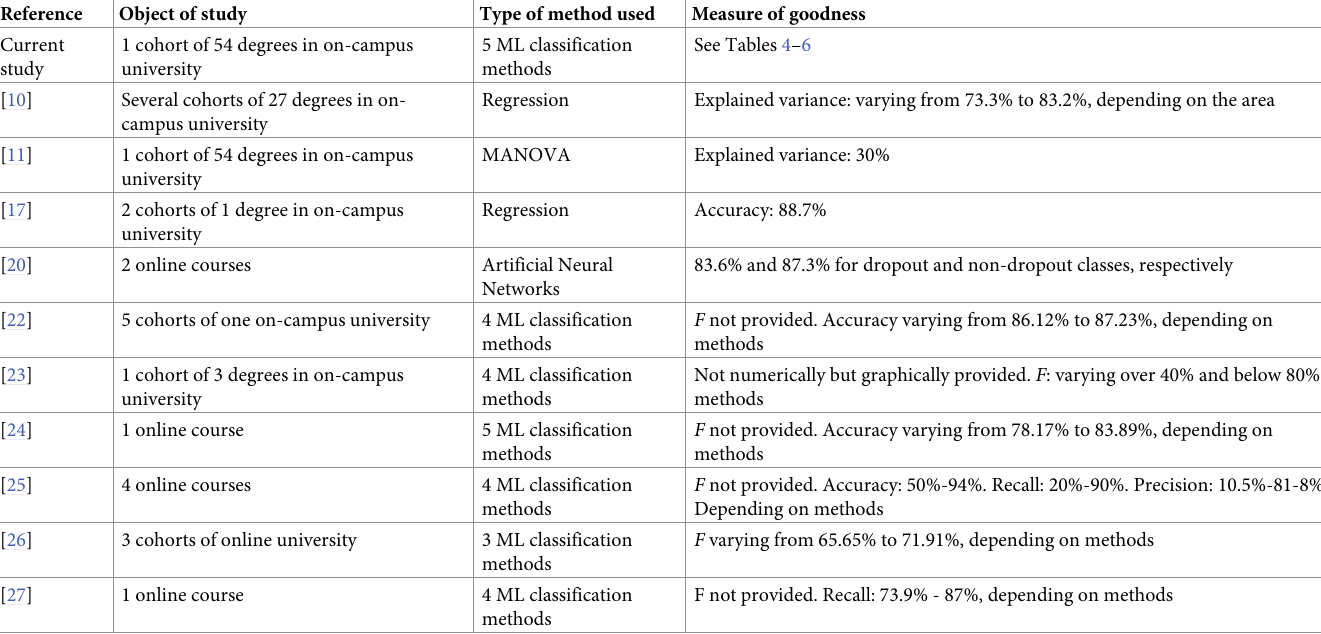
Table 7. Comparison of different